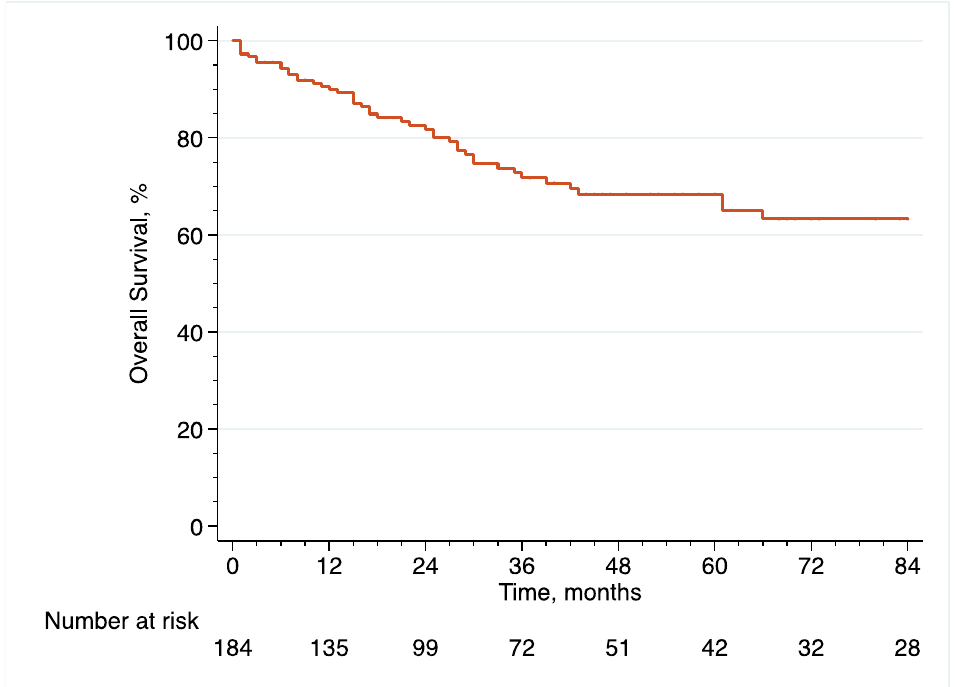
Figure 3. Kaplan–Meier curve that analyses the OS of included patients treated with eRC for HR- NMIBC.